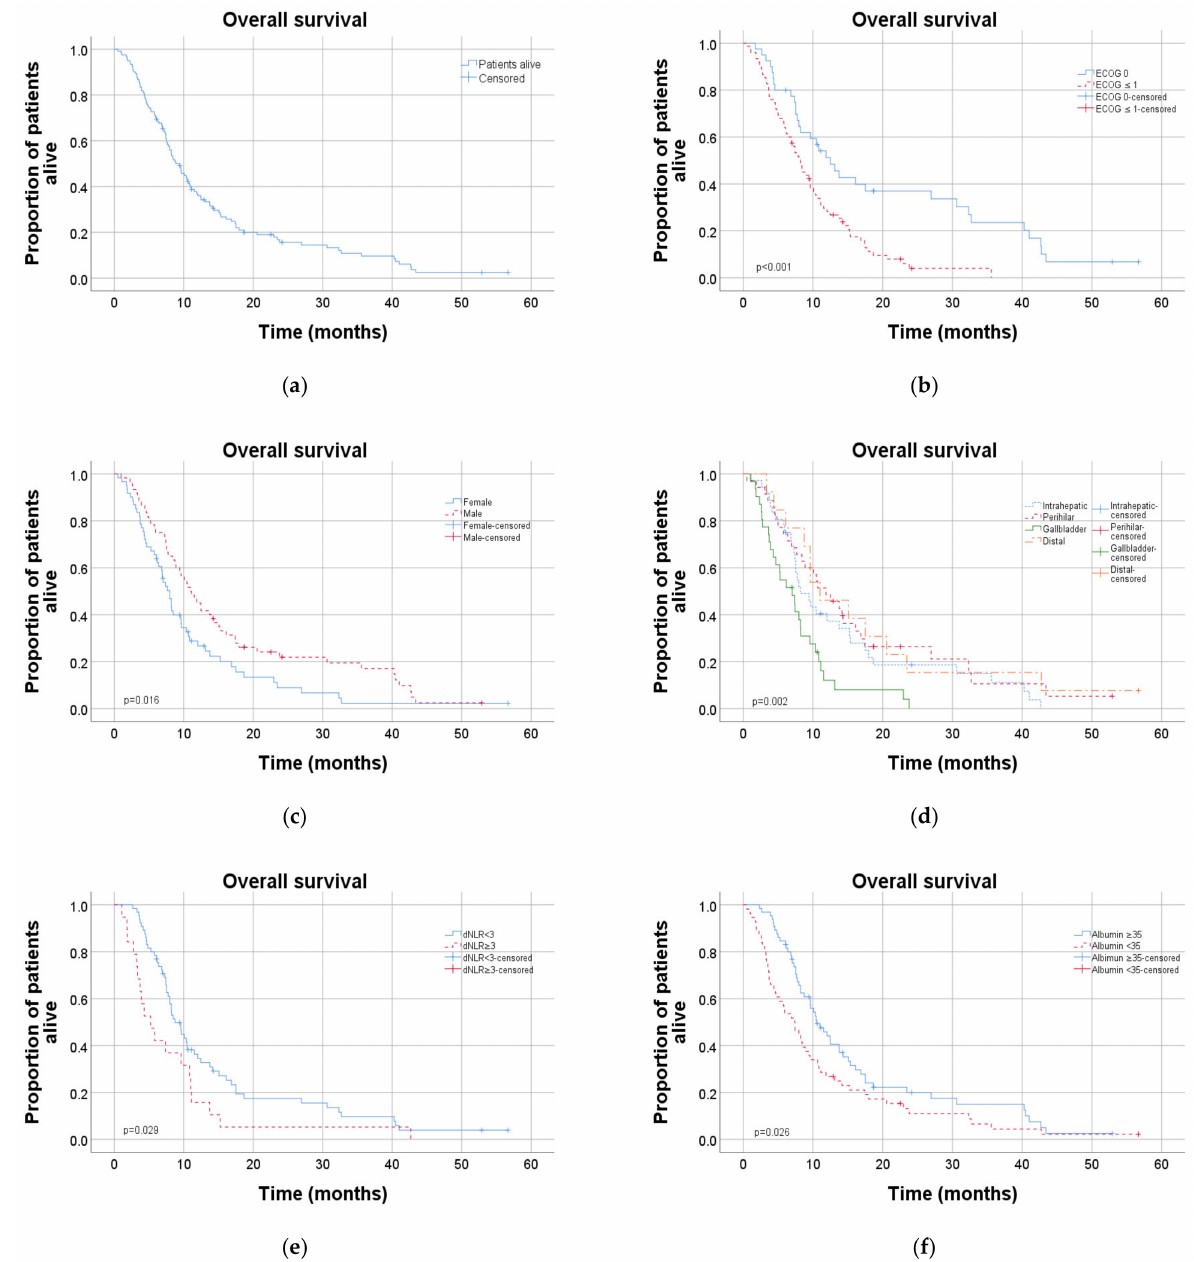
Figure 2. Kaplan–Meier diagrams showing overall survival for different subgroups: ( a ) total cohort, ( b ) performance status, ( c ) gender, ( d ) diagnosis, ( e ) dNLR at baseline and ( f ) serum albumin at baseline. dNLR: derived neutrophil/lymphocyte